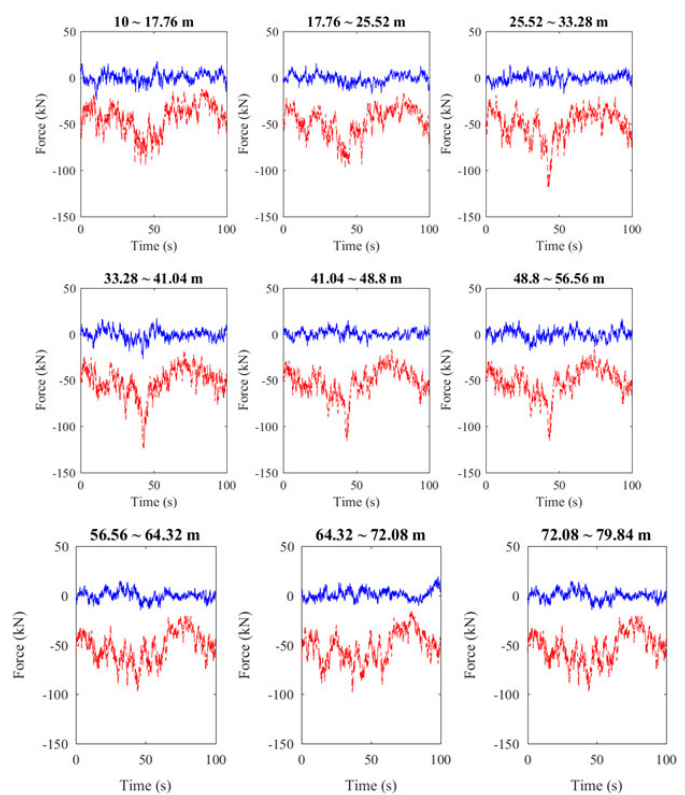
Figure 18. The force of each section of the tower under extreme wind conditions (blue line: x direction; red line: y